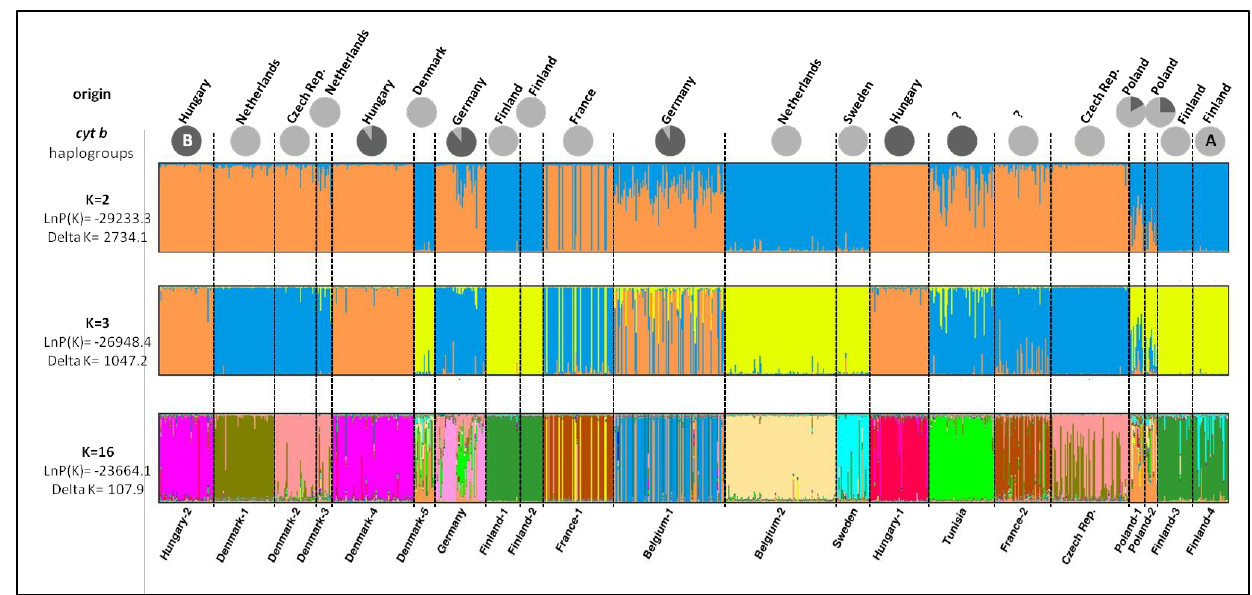
Figure 3. Bayesian individual assignment implemented in STRUCTURE for K = 2, 3 and 16 clusters without using geographical area as a priori. The y -axis represents the proportions of membership of pikeperch ( Sander lucioperca ) individual genotypes to each K inferred cluster. Assignment of each population to cyt b haplogroups (A or B) is also depicted with greyscale pie diagrams.